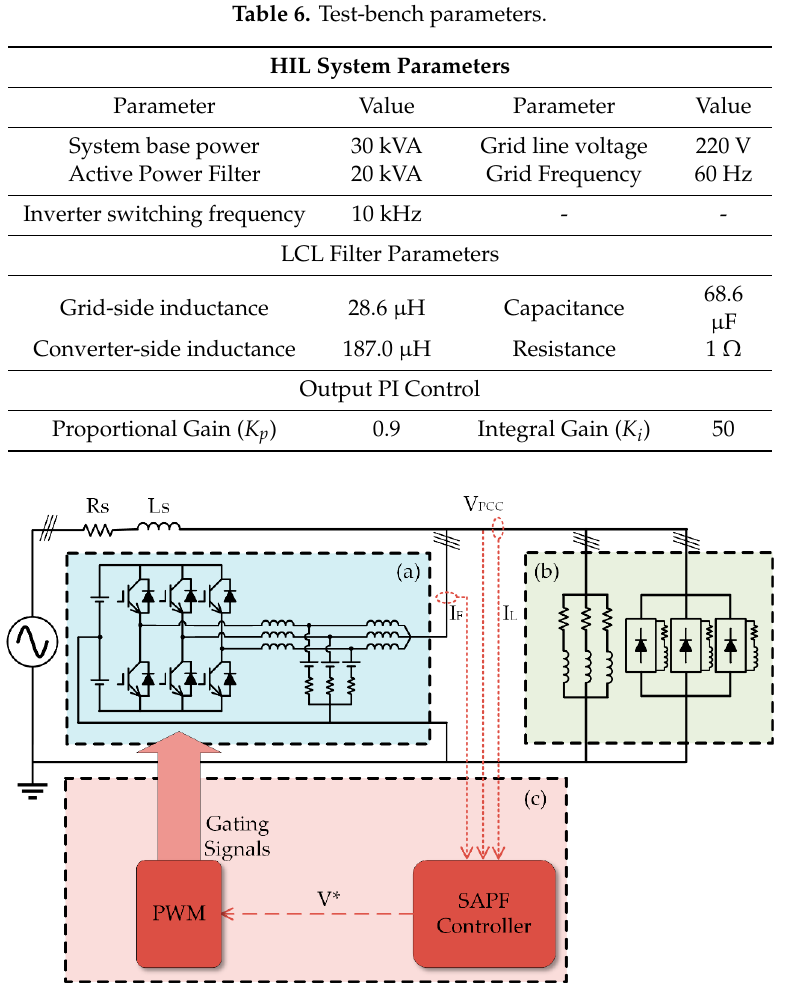
Figure 7. Software-in-the-loop (SIL) test-bench schematic. The controller and the power system are both simulated in real time in a Typhoon HIL environment. ( a ) Selective Active Power Filter. ( b ) Active and Passive Load. ( c ) SAPF controller and gating signals generator. Table 6. Test-bench parameters.